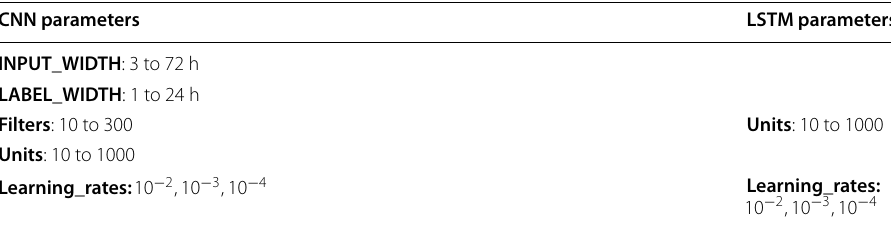
Table 1 CNN and LSTM parameters CNN parameters LSTM